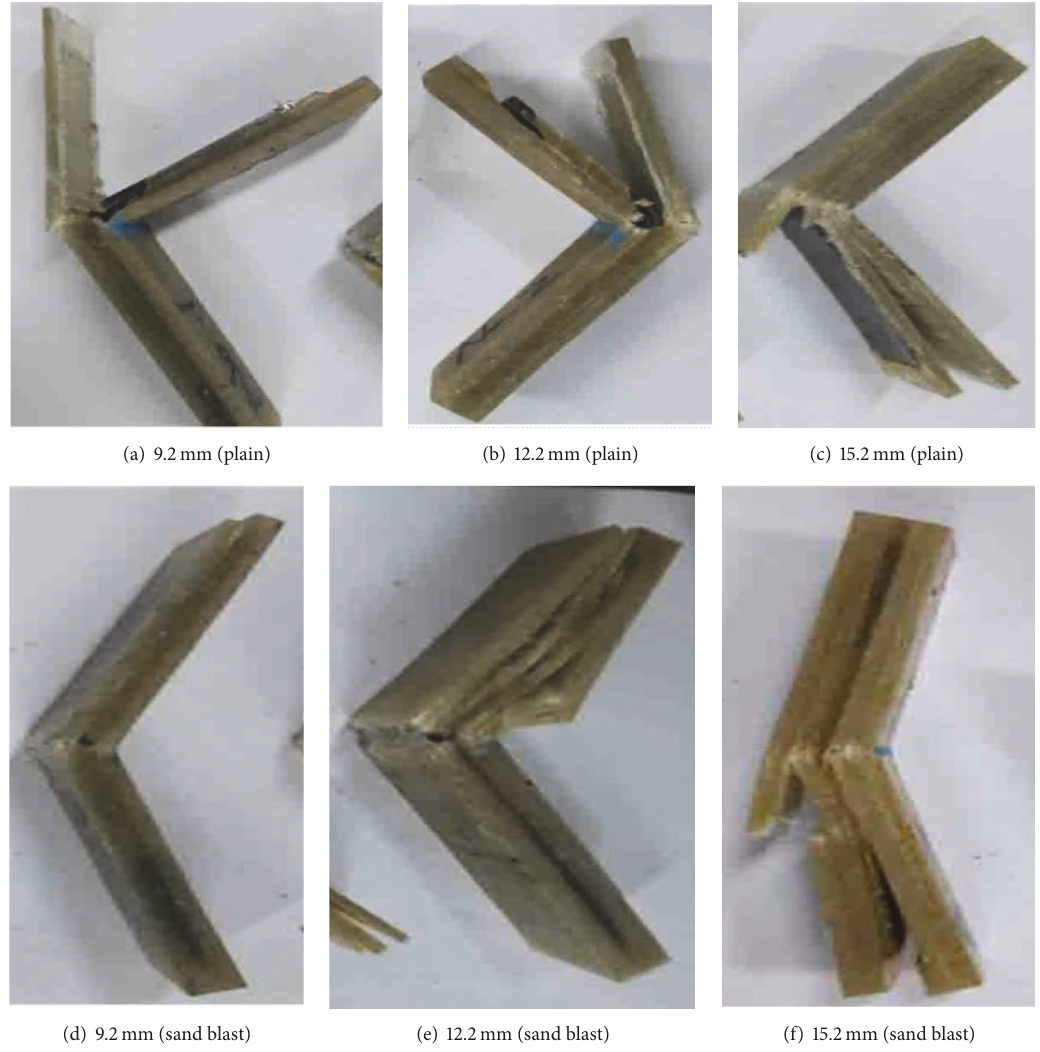
Figure 19: Fracture deformation with thickness of hybrid panels after Ca 2 Cl 2